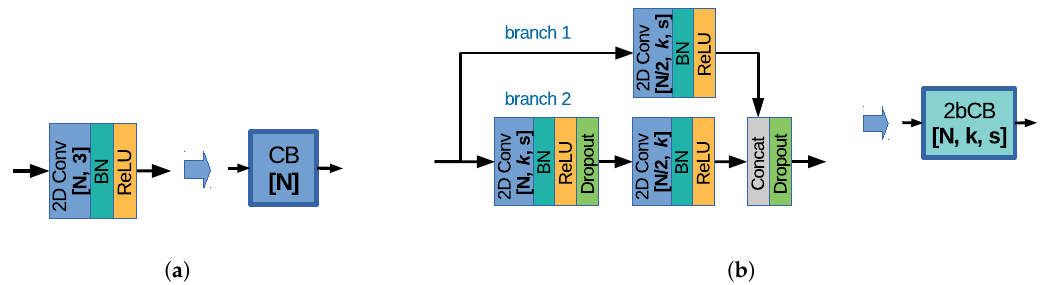
Figure 7. ( a ) Convolutional Block (CB) structure. ( b ) 2-branch Convolutional Block (2bCB)